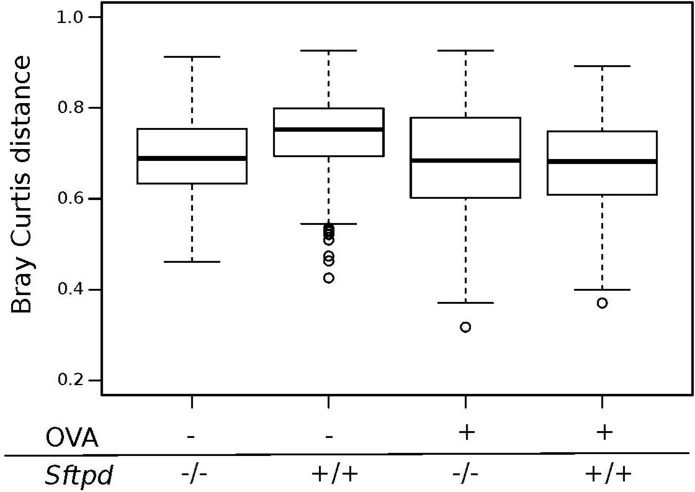
SP-D gut microbiota samples are more variable. Fig. 4 shows the Bray Curtis distance, which describes how different the caecum samples are within each experimental group compared to knockout naïve animals. (OVA- Sftpd −/-) and OVA treated groups (OVA+ Sftpd−/-, OVA Sftpd+/+), wild type (OVA- Sftpd+/+) animals without OVA exposure have the largest variation between mice (Kruskal-Wallis test, P-value = 1.32e-07).